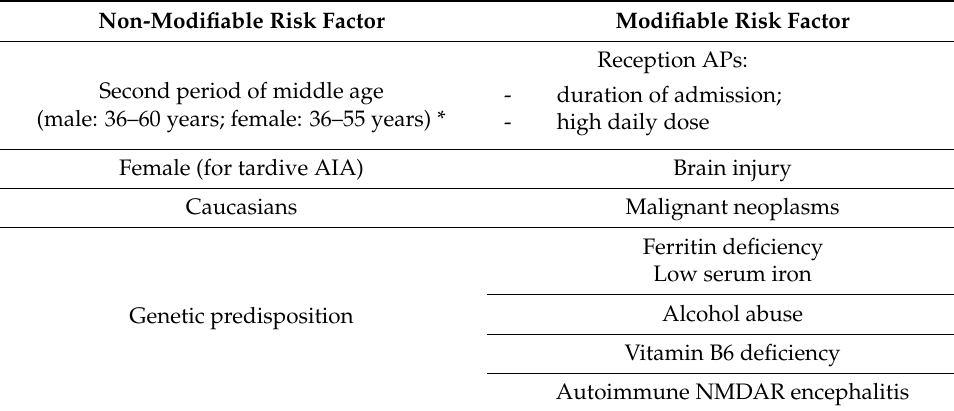
Table A3. Risk factors for antipsychotic-induced akathisia.